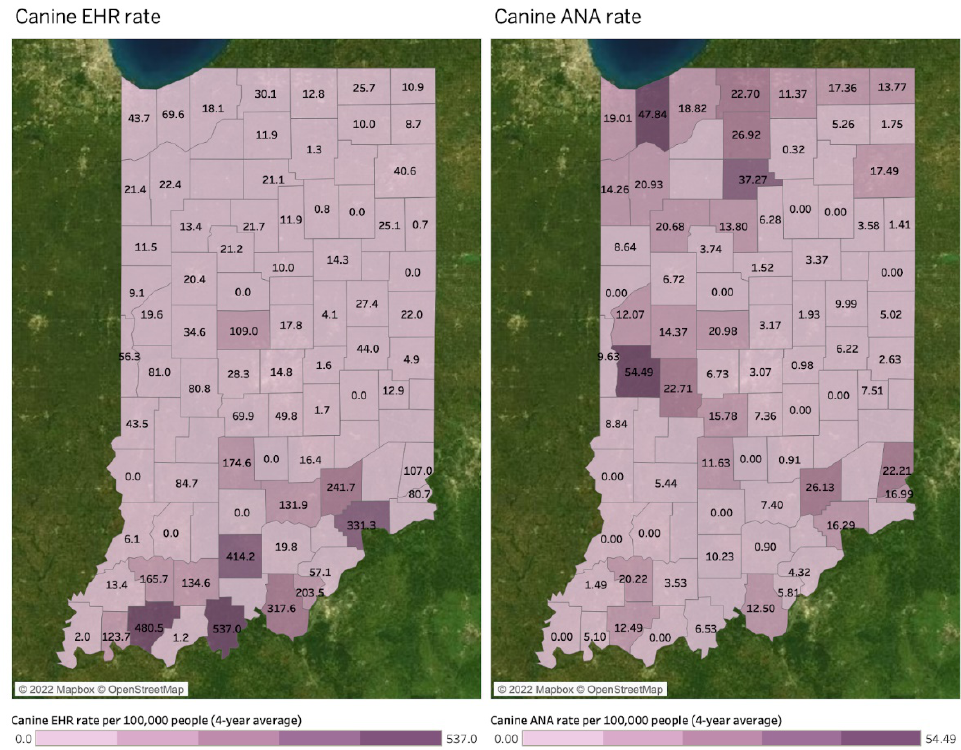
Figure 9. Deer mortality and canine EHR and ANA rates by county (4-year average between 2017 and 2020).